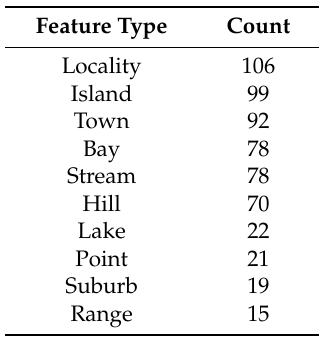
Figure 3. Spatial distribution of place names mentioned in the studies. Table 3. Most mentioned feature